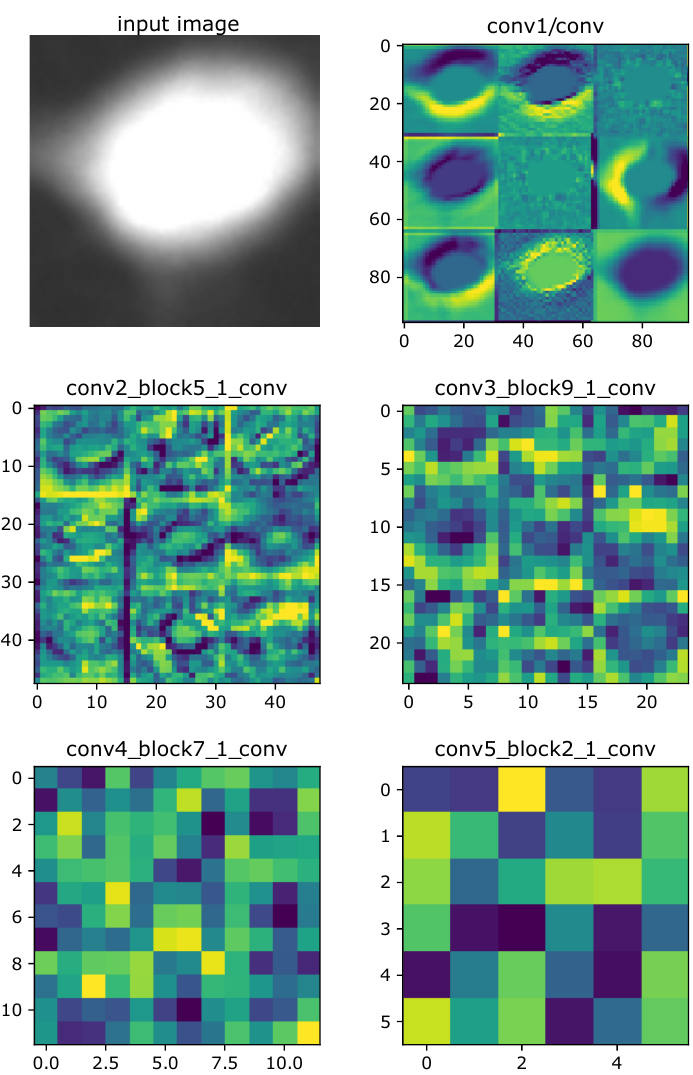
Figure 13. Activations of sample convolution layers in ResNet121 model. In early layers, cell edges are highlighted. In the middle, important sections are colored. The final layers are unrecognisable